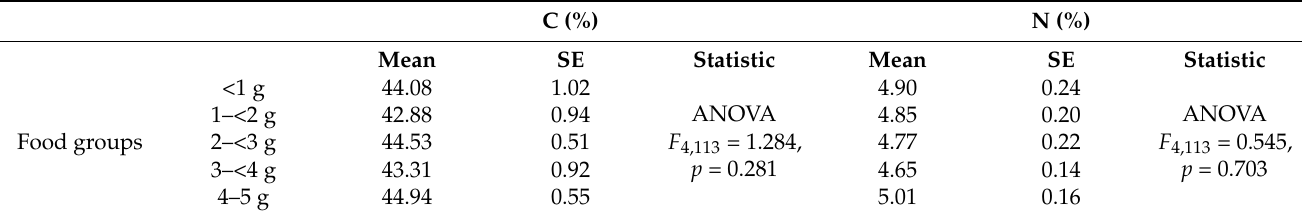
only factor significantly explaining the variation found in δ 13 C values (Table 3). Table 2. Faecal C and N values in relation to food